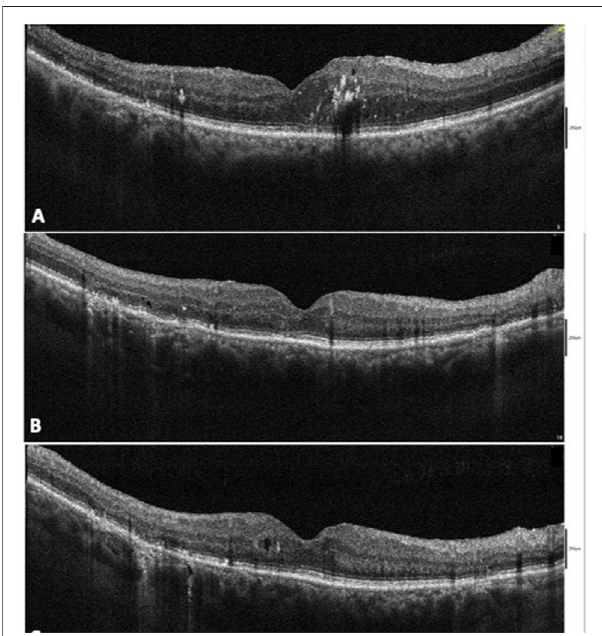
FIGURE 2 | Case of persistent diabetic macular edema (DME) after pars plana vitrectomy (PPV) for tractional diabetic macular edema (TDME) treated withsubthresholdmicropulseyellowlaser(SMYL) (A) .At3monthsafterSMYL treatment, a reduction in the macular thickness with a normalization of the outer retinal layer was seen (B) . A macular thickness within the normal limits and the presence of a microcysts in the macular area at 6-month follow- up were seen (C) .